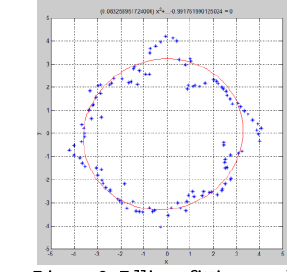
Figure 6. Ellipse fitting result